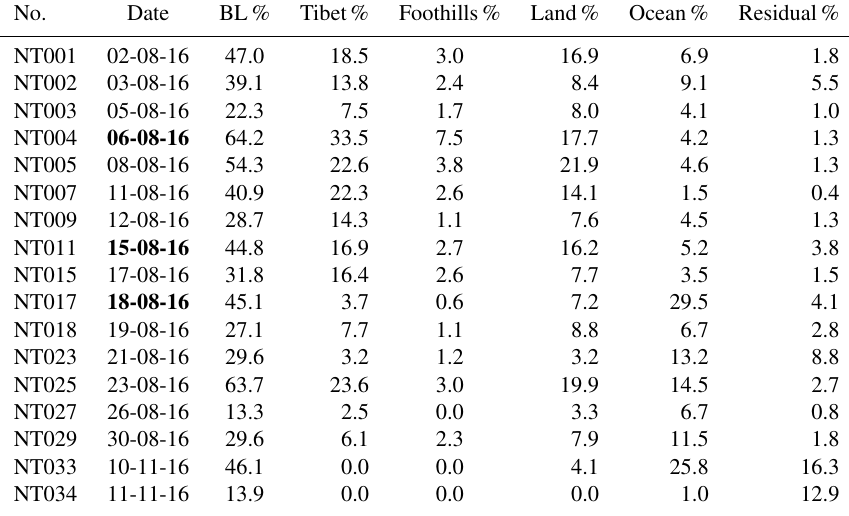
Table 3. Fraction of 40-day backward trajectories (for all soundings in August 2016) which end in the boundary layer (BL), separated into the Tibetan Plateau (“Tibet”), the Himalayan foothills (“Foothills”), the remaining continental area (“Land”) and the maritime area (“Ocean”) in a latitude–longitude box from 60 to 160 ◦ E and from 5 ◦ S to 45 ◦ N shown in Fig. 6 and finally all remaining trajectories that reach the BL outside the latitude–longitude box (Residual). The fraction of trajectories which are from the LT, UT and LS (i.e. do not reach the BL within a time period of 40d as shown in Table 2) is the difference between 100% and the fraction of the BL in %. Tibet is defined as the altitude above a geopotential (cid:56) of 40000m 2 s − 2 (about 4000m), the Foothills as 21000 < (cid:56) < 40000m 2 s − 2 (about 2000–4000m) and Land as (cid:56) < 21000m 2 s − 2 (below about 2000m). The dates of three balloon flights representing typical situations encountered during the measurements in August 2016 are marked in bold type (see Table 2).